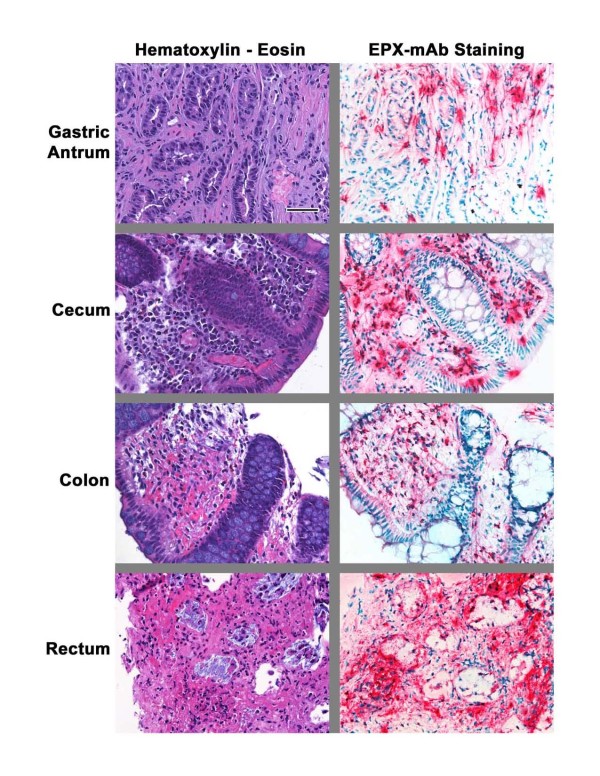
H&E and anti-EPX staining of GI tissues. EPX-mAb-based immunohistochemistry provided evidence of both tissue infiltrating eosinophils and eosinophil degranulation in GI biopsies from the patient described in this cse report. In contrast to sections stained with Hematoxylin-Eosin (left panels) which displayed only nominal evidence of eosinophil infiltration and degranulation, serial sections subjected to EPX-mAb-based immunohistochemistry (right panels) displayed significant evidence (magenta staining areas) of both eosinophil infiltration and degranulation (extra-cellular deposition of granules and/or free-EPX within the tissue matrix). Each photomicrograph was obtained at an original magnification of 400× (0.29 mm2 field of view). Scale bar = 50 μm.